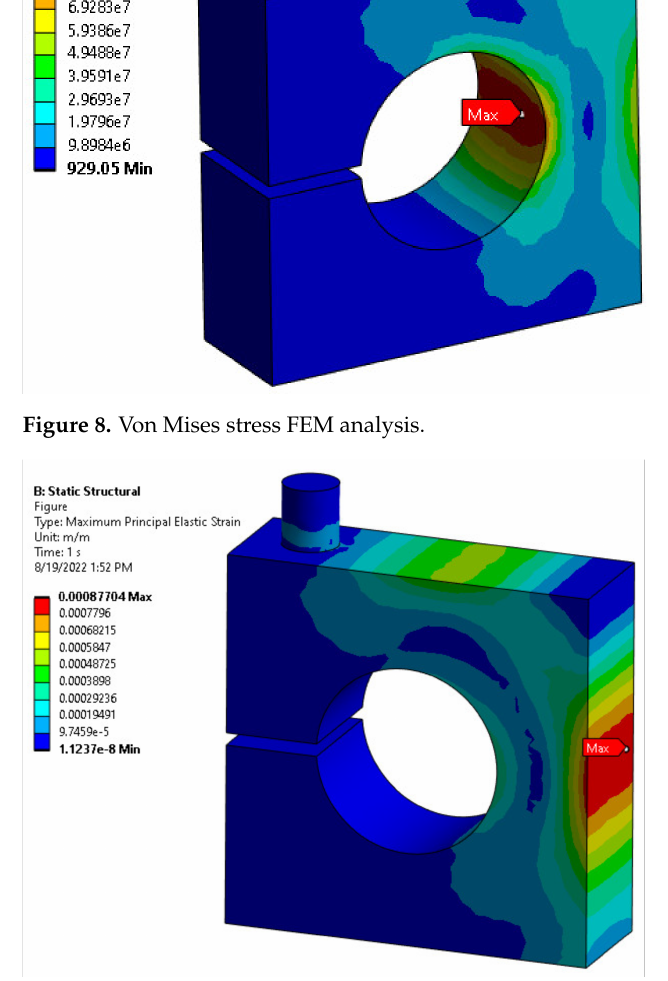
Figure 9. Maximum principal strain FEM